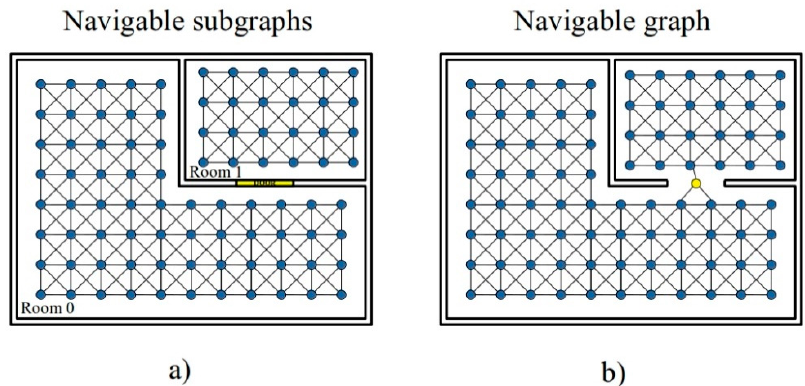
Figure 12. ( a ) A subgraph is generated separately for each room. ( b ) The global graph consists of all subgraphs joined by new nodes corresponding to door positions (yellow).